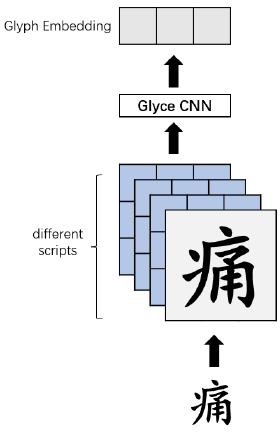
Figure 6. Glyce character embedding.